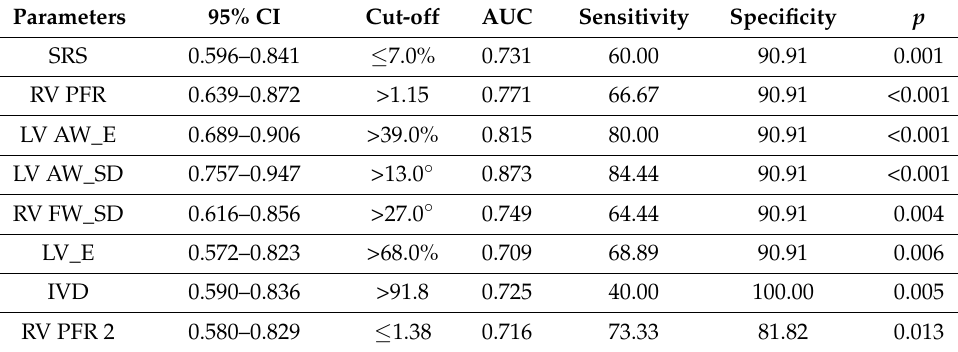
Table 3. The ROC analysis results.